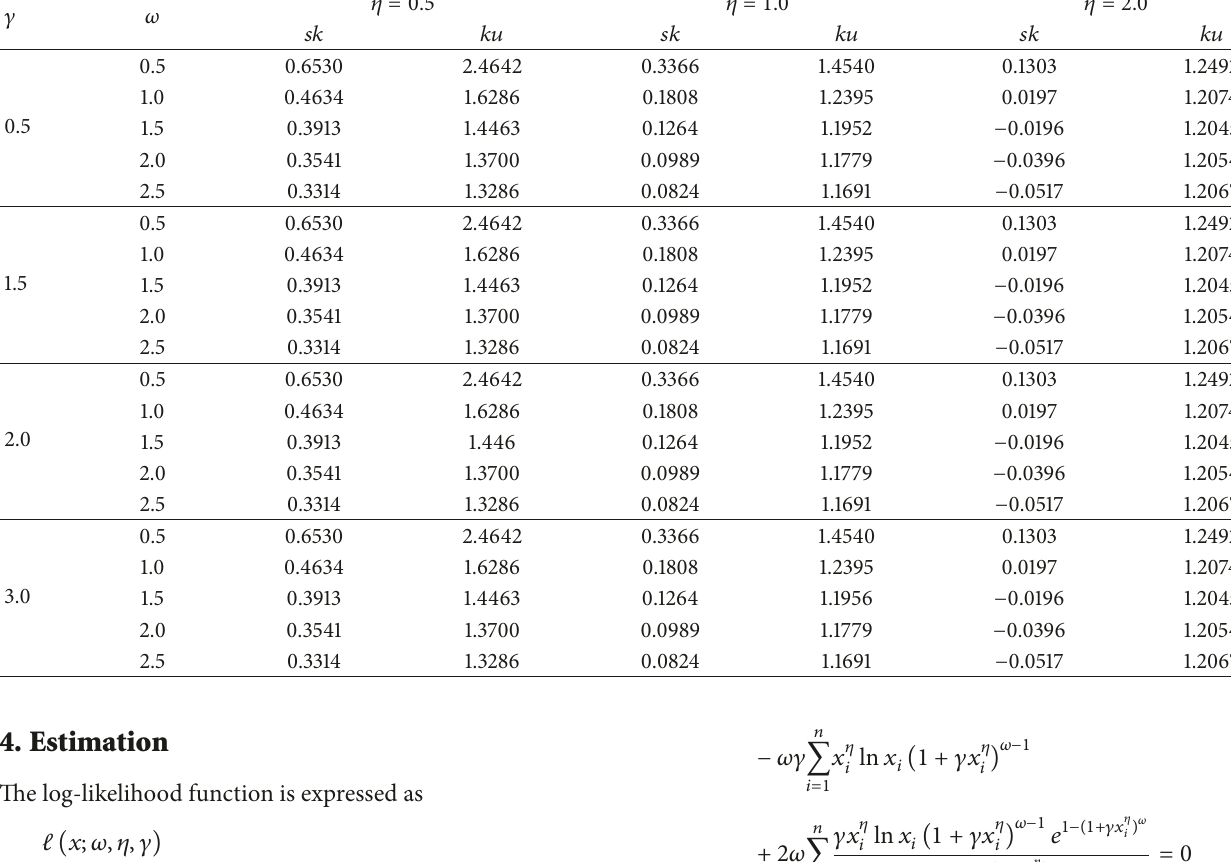
Table 1: Skewness and kurtosis of HLGW for different values of 𝜔 , 𝜂 , and 𝛾